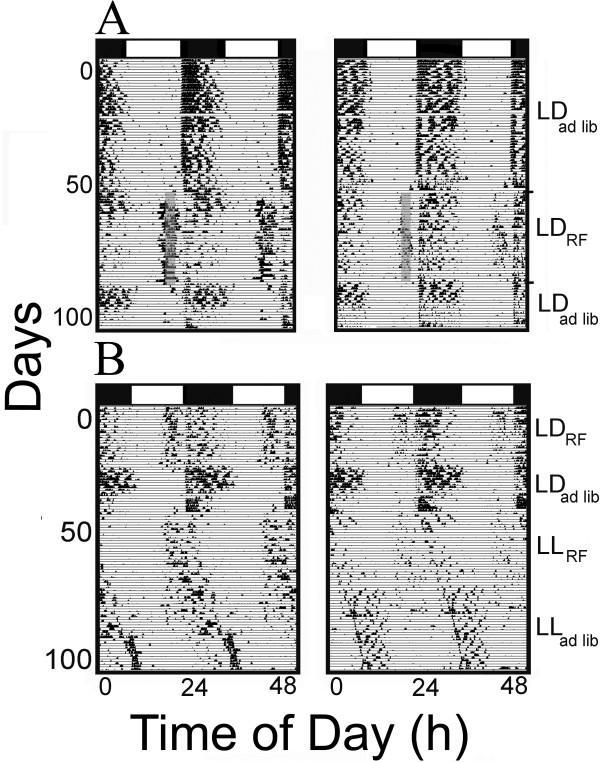
FAA and FEO in A. cahirinus. Representative actograms showing the effects of food restriction (RF) paradigms in LD (A) and LL (B) on running-wheel activity of four mice. The shaded grey region indicates a 2h period of restricted feeding (16:30 – 18:30 h).